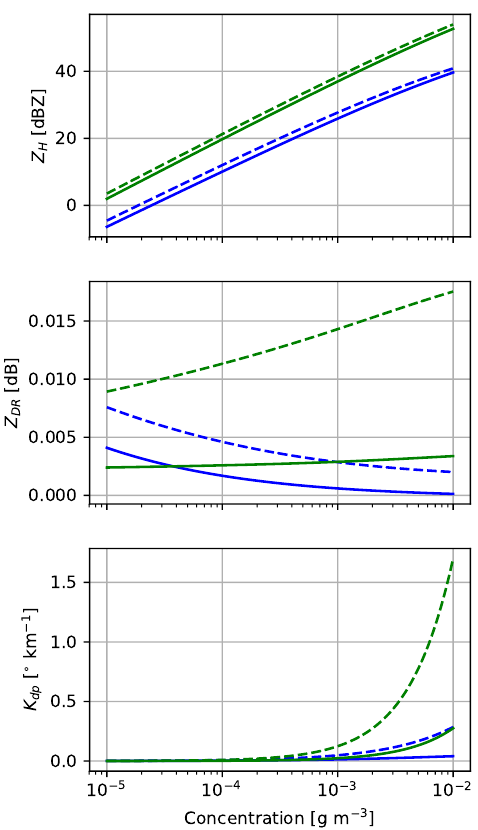
Figure 7. Polarimetric variables at X-band (9.41GHz) as a func- tion of the mass concentration for snow and graupel when using canting angle and aspect-ratio parameterizations from the literature (Ryzhkov et al., 2011) (solid line) and when using the parameteri- zation based on MASC data (dashed